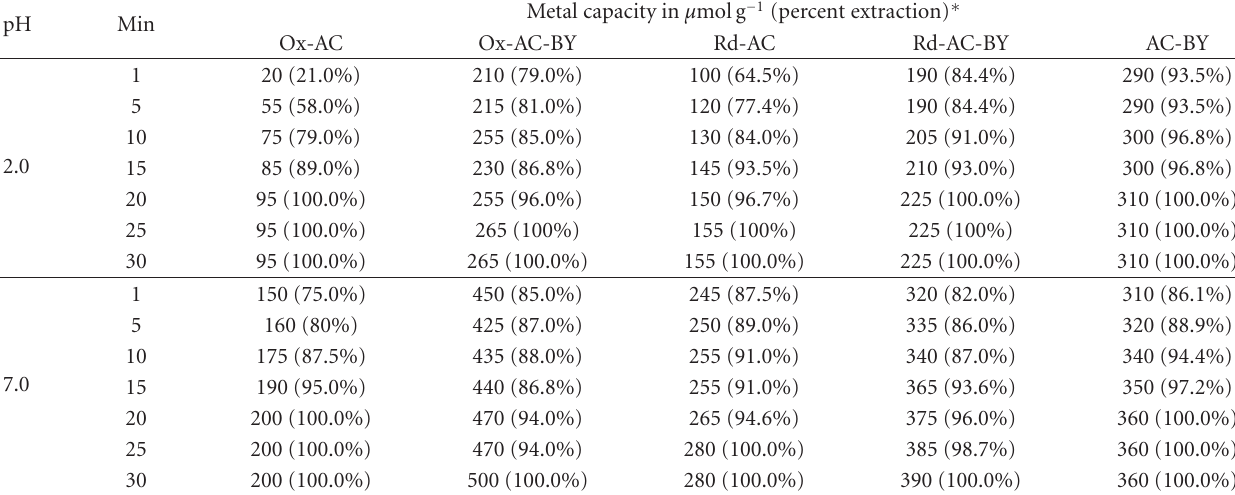
Table 3: E ff ect of contact time on sorption capacity and percent extraction of lead by hybrid sorbents and biosorbents in pH 2.0 and 7.0 solutions.